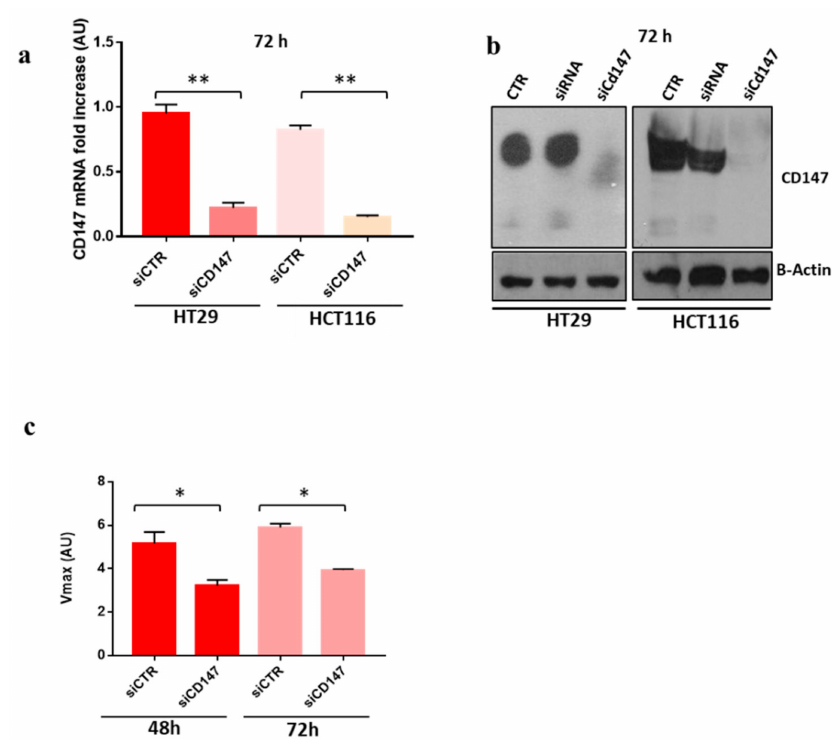
Figure 6. Knock-Down of CD147 Gene By RNA Interference. ( a , b ) The knock down of CD147 gene was confirmed by RT-PCR (left) and western blot (right). ( c ) The rate of cell di ff erentiation, assessed by phosphatase alkaline assay, was inhibited in HT29 cells transfected with siRNA for CD147. Data are representative of three independent experiments. siCTR = cells transfected with non-targeting control siRNA; siCD147 = cells transfected with siRNA for specific CD147. *, p ≤ 0.05; **, p ≤ 0.005.